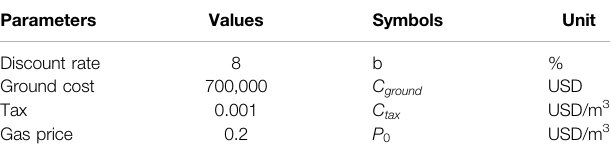
TABLE 3 | Parameters for NPV